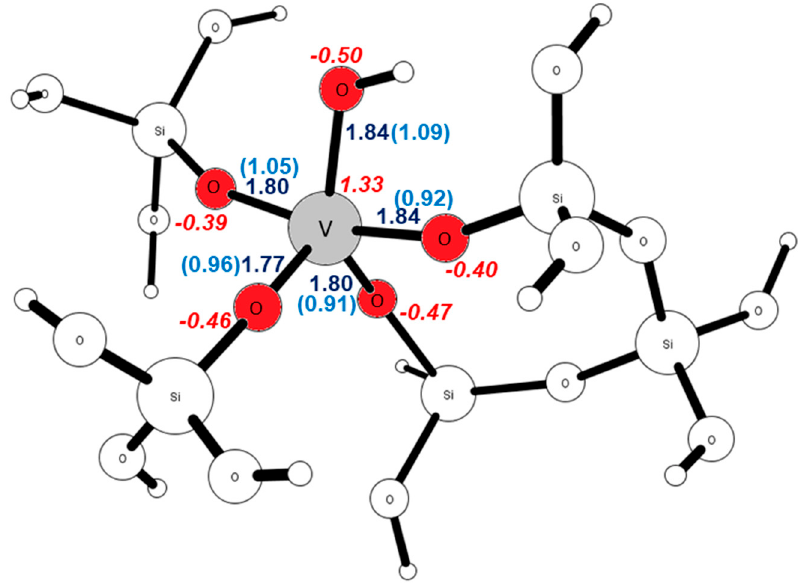
Figure 3. The parameters of the V–OH center in the T2 position (navy—bond lengths in Å; blue, in parentheses—bond order indices; red—Mulliken charges).